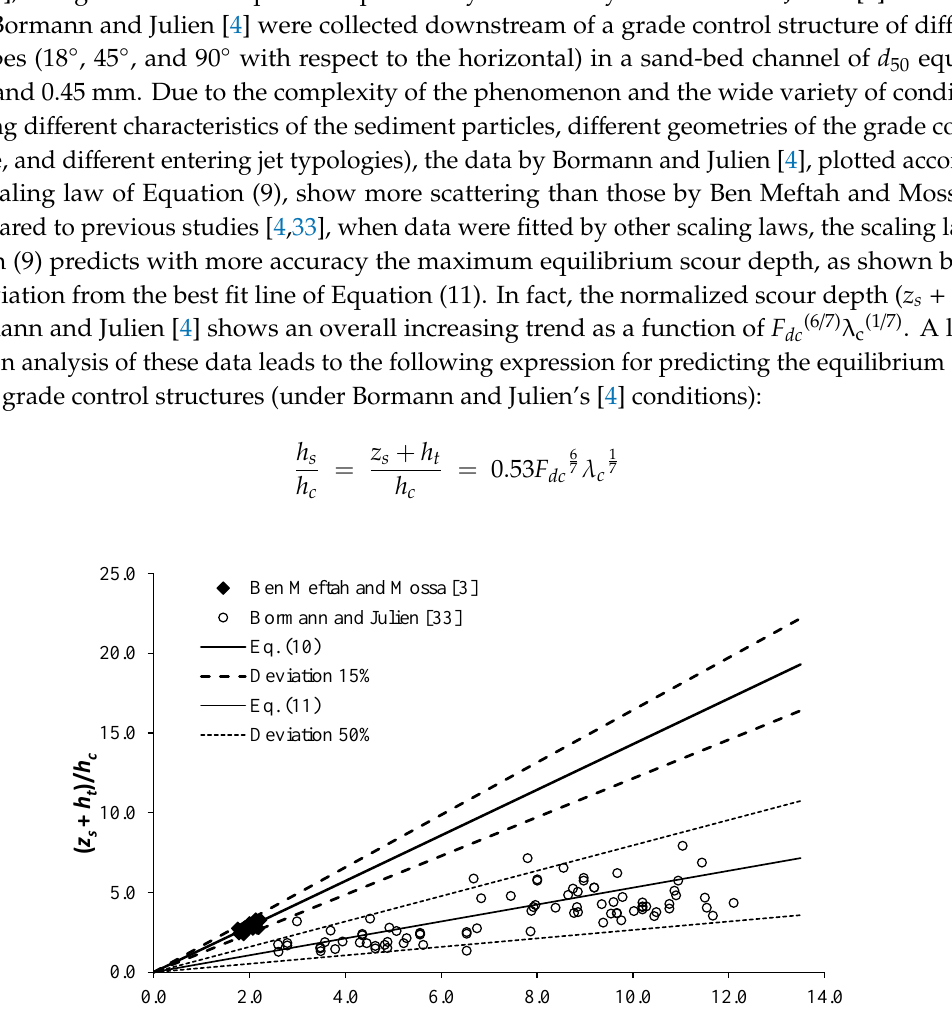
Figure 12. Validation of the scaling law of the maximum scour depth using data obtained by Bormann and Julien [4] downstream of grade control structures of different features and with sediment sizes of d 50 ranging between 0.30 and 0.45 mm, Re g ranging between 396 and 2093 and with relative roughness in the range of 10 − 4 < λ c < 10 − 2 . The scaling law is validated for σ = − 5 / 3, in the energy inertial subrange.